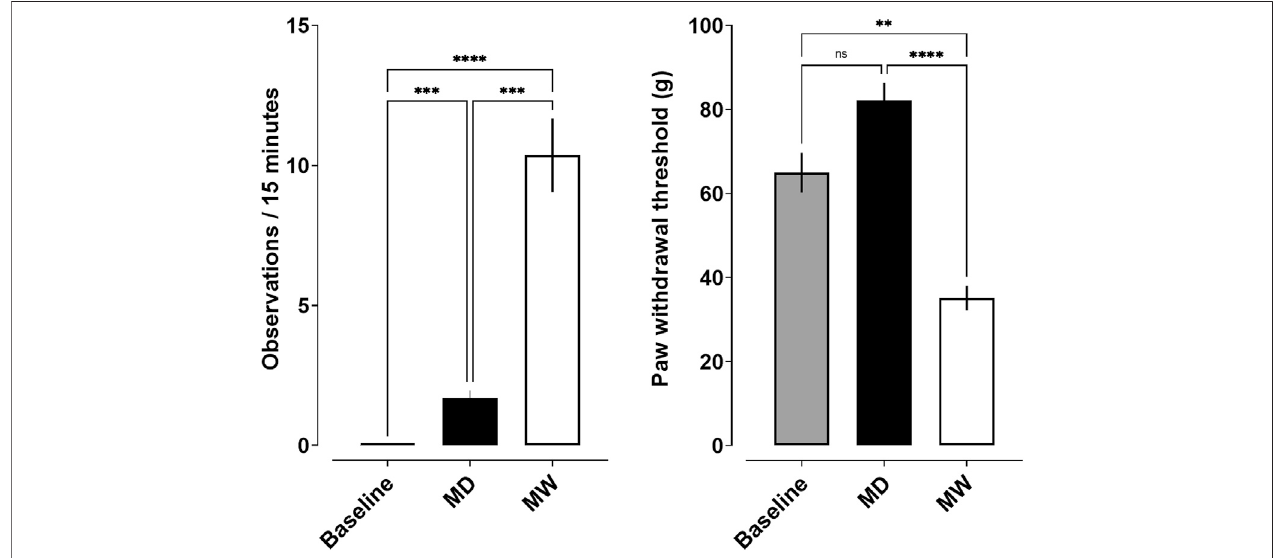
FIGURE2| Somaticwithdrawalsigns (left) andmechanicalnociception (right) andasafunctionofstateofwithdrawal.Datarepresentthemean( ± SEM),andeach bar represents 10 – 12 rats. Ns indicates not signi fi cant, **** indicates p < 0.0001, *** indicates p < 0.001, and ** indicates p < 0.01.